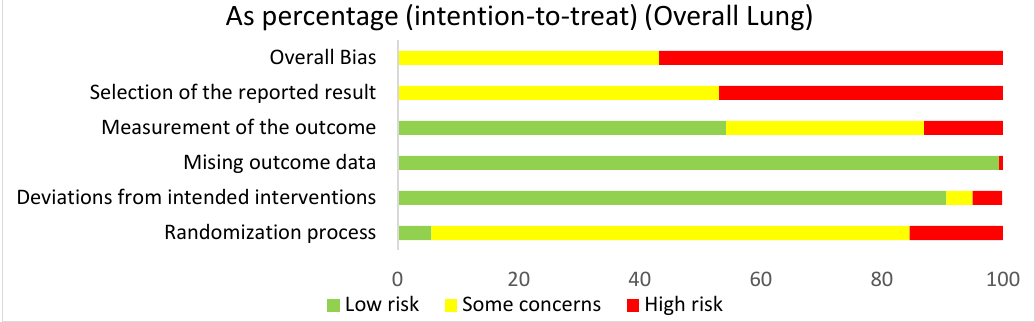
Figure 3. The overall risk of bias for all of the lung studies was a high risk of bias (56.8%) and some concerns (43.2%). The selection of the reported result had a high risk of bias (46.9%) and some concerns (53.1%). The measurement of the outcome had a high risk of bias (13%), some concerns (32.7%), and low risk of bias (54.3%). The missing outcome data domain had a low risk of bias (99.4%) and a high risk of bias (0.6%). Deviations from intended interventions had a low risk of bias (90.7%), some concerns (4.3%), and high risk of bias (4.9%). The randomization process had a high risk of bias (15.4%), some concerns (79%), and low risk of bias (5.6%).